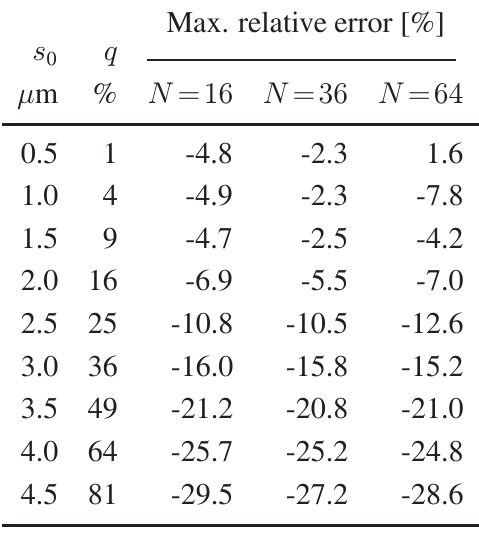
simulated with the m = 1 . All other simulation h Max. relative error